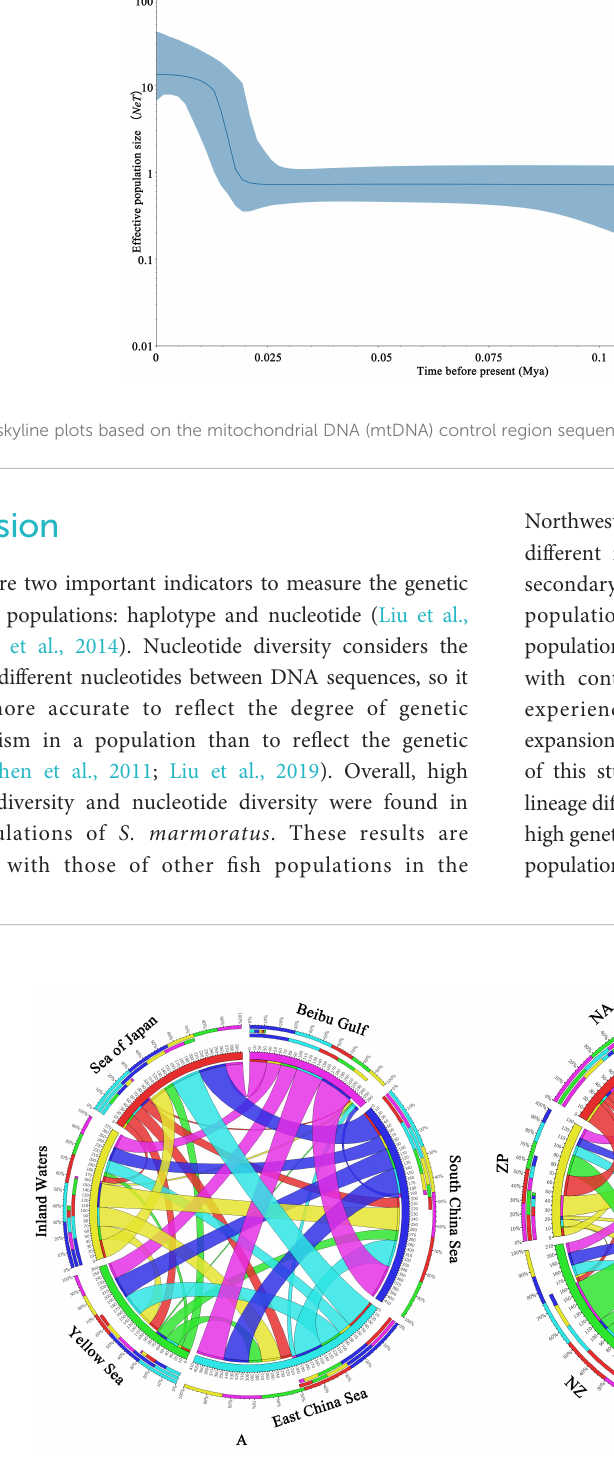
FIGURE 6 (A) Gene fl ow of Sebastiscus marmoratus populations across fi ve marginal seas and one inland water. (B) Gene fl ow between six populations of S. marmoratus in southern China. Different colors represent different marginal seas (A) or populations (B) . The thickness of the color bands indicates the extent of gene fl ow. QZ , Qingzhou; HP , Hepu; WS , Wushi; NZ , Naozhou; ZP , Zhapo; and NA ,